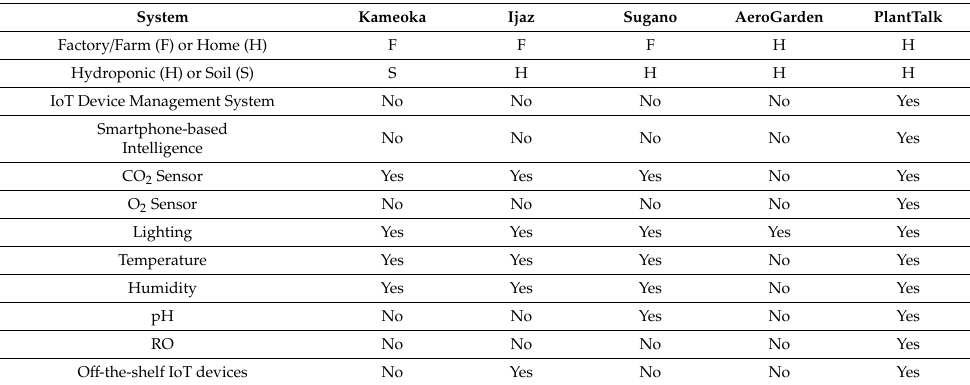
Table 1. Comparisons of Plant-Care